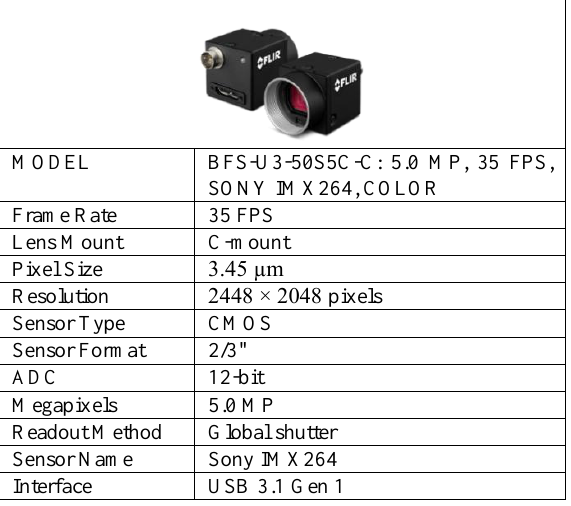
Table 1: Imaging System